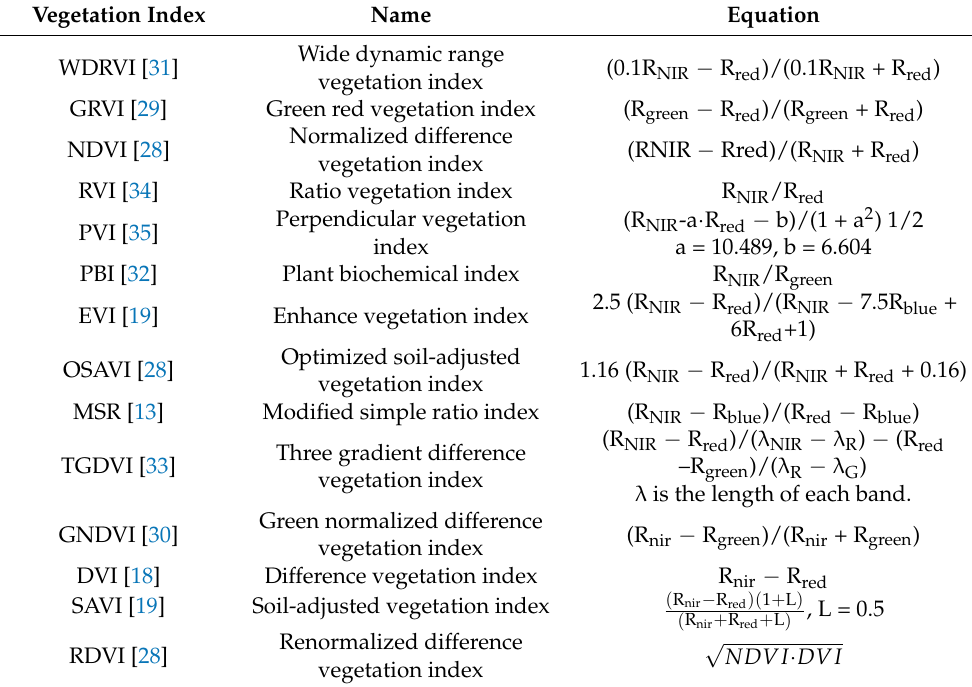
Table 1. The vegetation index of UAV’s multi-spectral data.